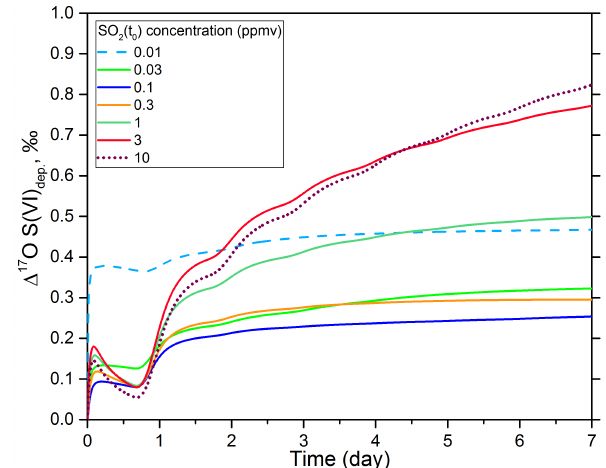
Figure 9. Temporal evolution of (cid:49) 17 O(S ( VI ) ) dep . at different ini- tial concentrations of SO 2 . The dashed line represents simulation where H 2 O 2 is the major SO 2 oxidant, straight lines are simu- lations for which OH is the major oxidant, and dotted lines are simulations for which O 2 / TMI is the major pathway of oxidation. The equivalent pathways contributions are summarized in Table